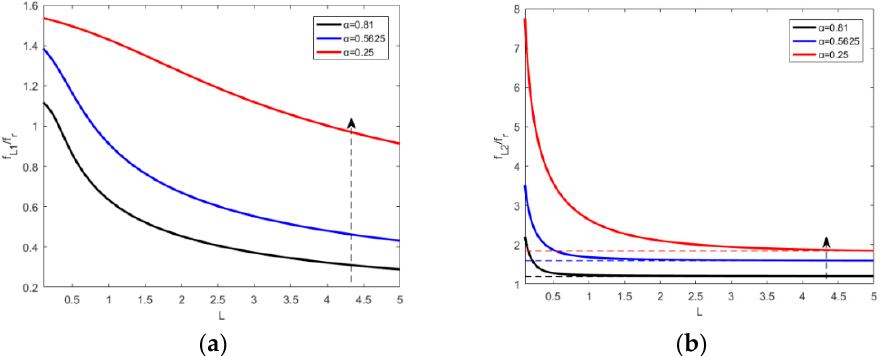
Figure 19. The change of piezoelectric resonance frequencies with inductance value. ( a ) f L1 and ( b ) f L2 .